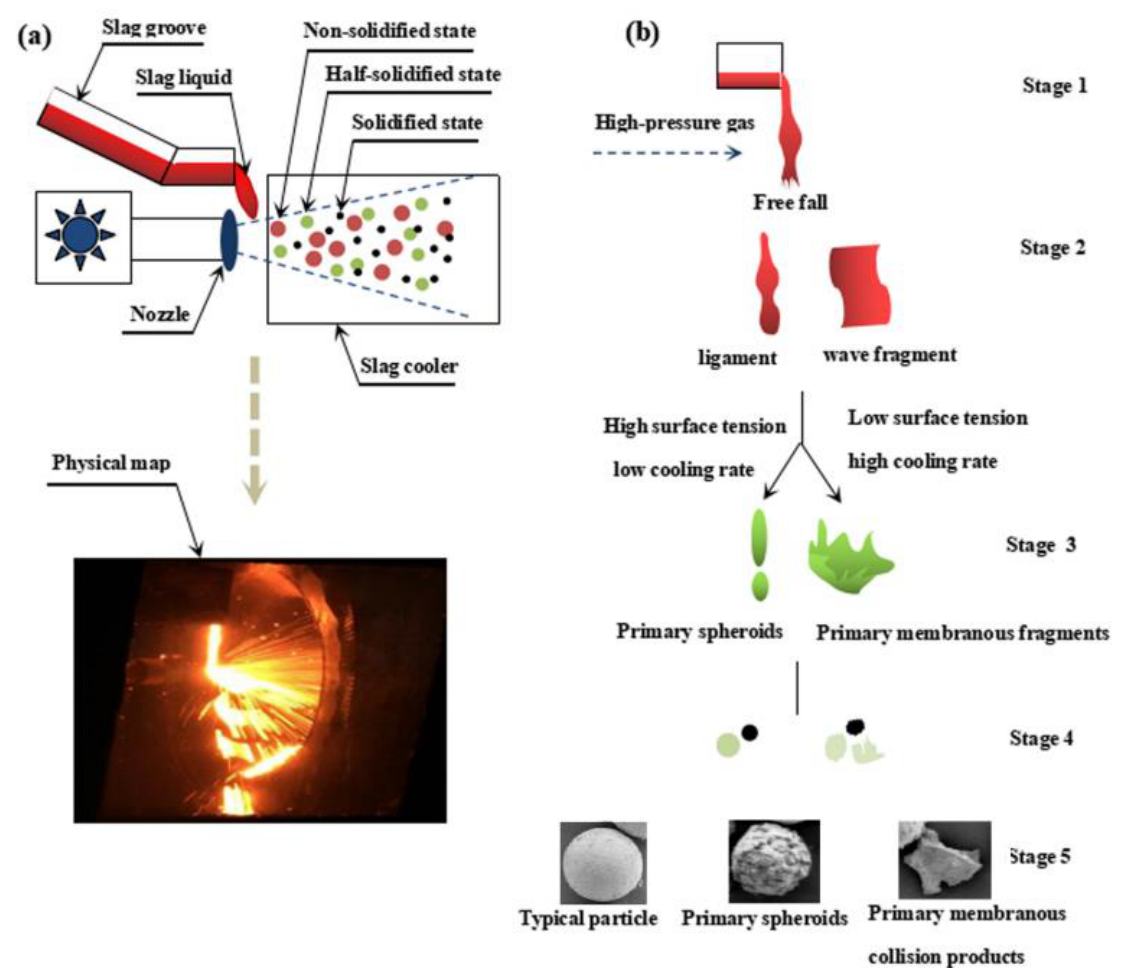
Figure 4. Schematic of the sample formation (( a ) Physical map;( b ) Bead formation in five stages).